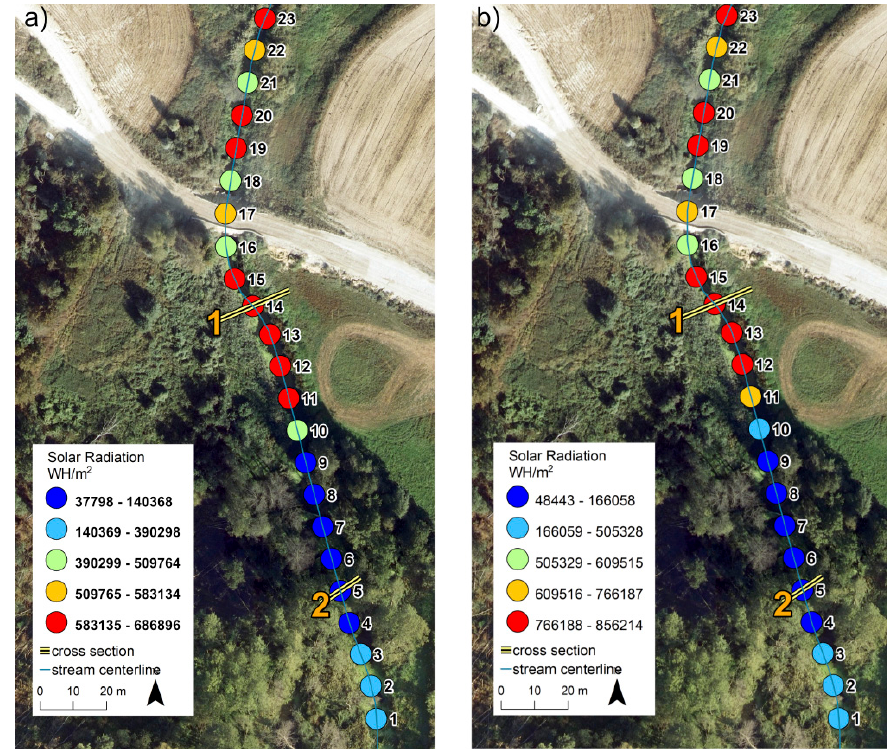
Figure 6. Distribution of total solar radiation (WH·m − 2 ) reaching the substrate in the investigated reach of the Wełna River for: ( a ) the period of April–September, ( b ) the annual period. Table 4. Solar radiation (10 3 ·WH·m − 2 ) at points located along the investigated reach of the Wełna River.